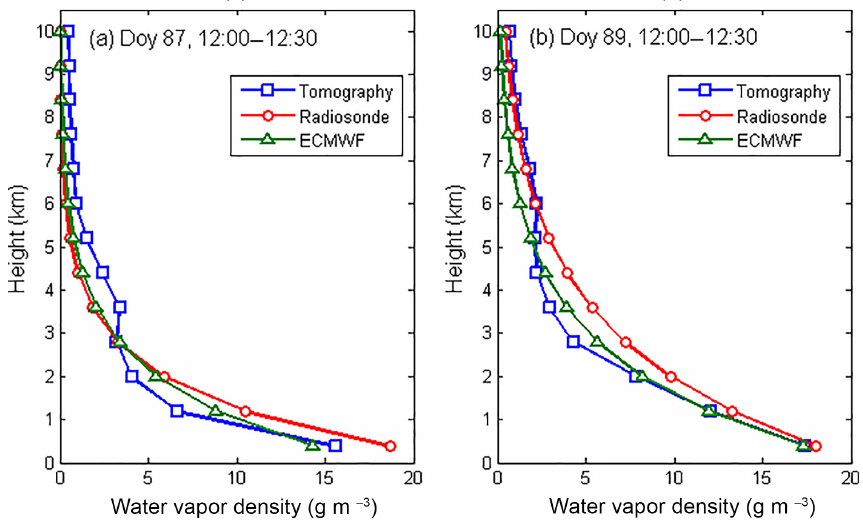
Figure 7. Water vapor density profile derived from radiosonde, ECMWF, and troposphere tomographic results. Time periods in panels (a) and (b) are 12:00–12:30UTC on DoY 87 and 89 in 2014,